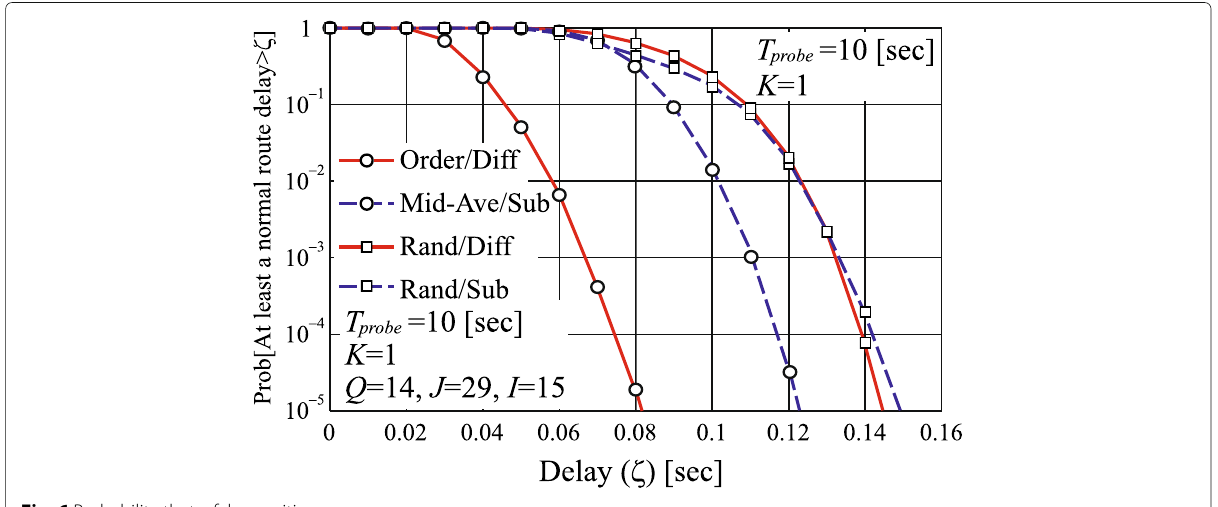
Fig. 6 Probability that a false positive error